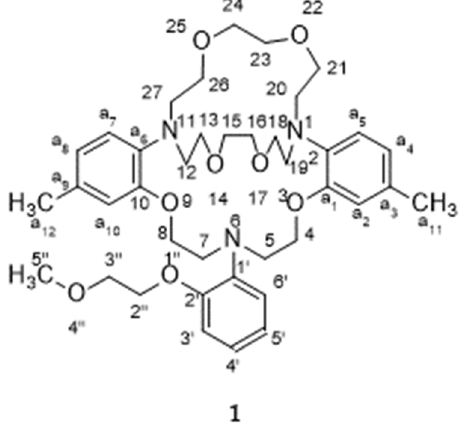
Figure 2. Triazacryptand as free ligand with numbering according to NMR assignments.